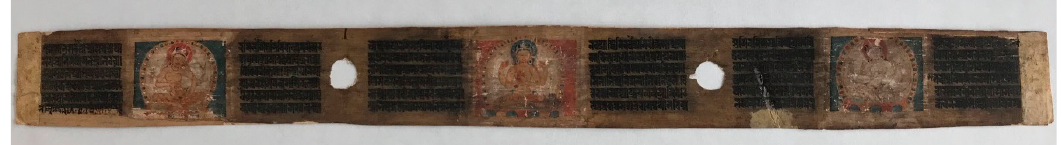
Figure 1. Prajñ ā p ā ramit ā flanked by two female figures, fol. 1v. Perfection of Wisdom in Eight Thousand Lines: A ṣṭ as ā hasrik ā Prajñ ā p ā ramit ā -s ū tra , 1119. India and Nepal. Gum tempera and ink on palm leaf.